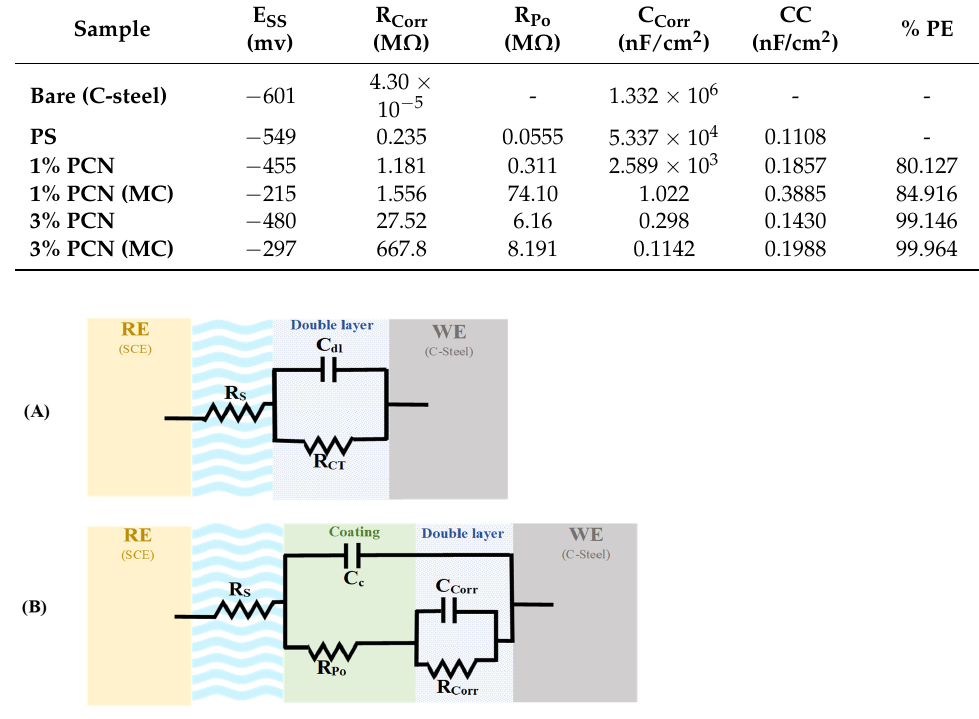
Figure 6. Schematic diagram of the equivalent circuits ( A ) Randles, and ( B ) for free and impregnated PCNs. Also, the percentage protection efficiency (%PE) for the coated substrate relative to the pure PS has an average value of approximately 99%, which was estimated using the fol- lowing equation [43]: